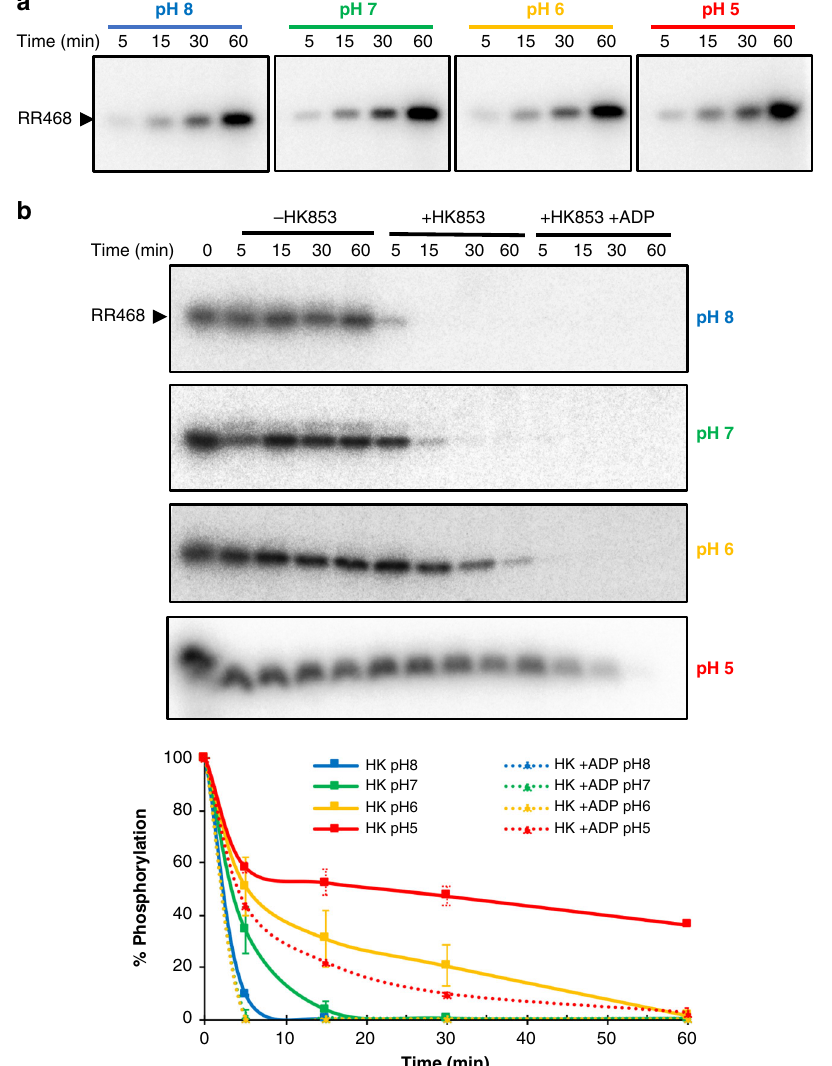
Fig. 4 RR468 phosphorylation and dephosphorylation at different pHs. a Time course of RR468 phosphorylation upon incubation with acetyl-phosphate (AcP) as phosphodonor at different pHs. b Phosphatase activity of HK853 over phosphorylated RR468 in the absence and presence of ADP. Gels correspond to a representative experiment and quanti fi cation of three independent experiments are plotted. Error bars represent SD. Source data are provided as a Source Data fi